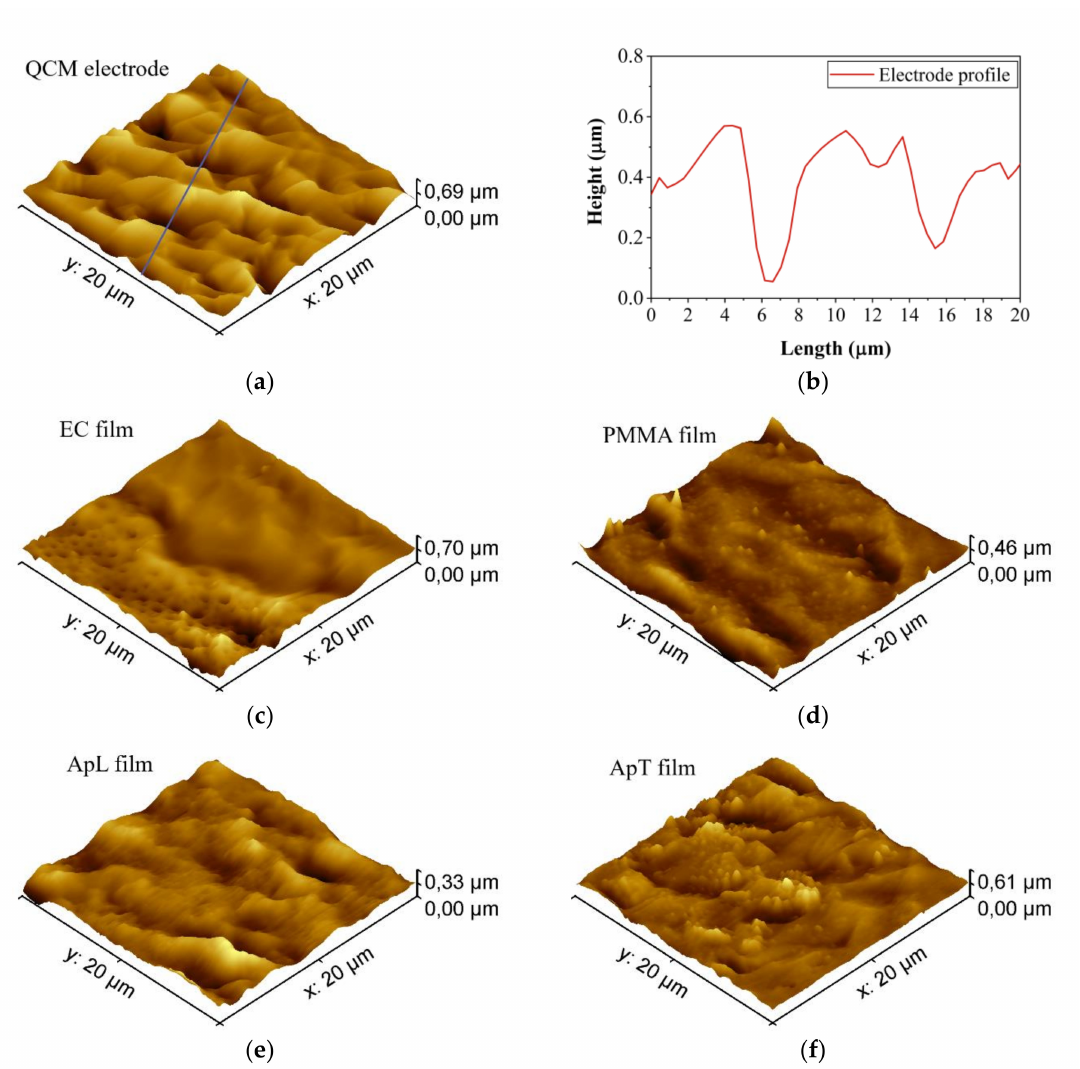
Figure 2. AFM images for ( a ) bare electrode, ( b ) bare electrode profile measured at the blue line of ( a ), ( c ) EC, ( d ) PMMA, ( e ) ApL, and ( f ) ApT sensing films deposited onto the QCM